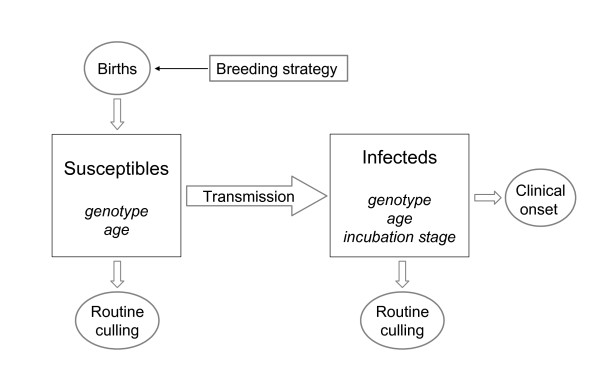
Structure of our mathematical model of scrapie transmission in a sheep flock.